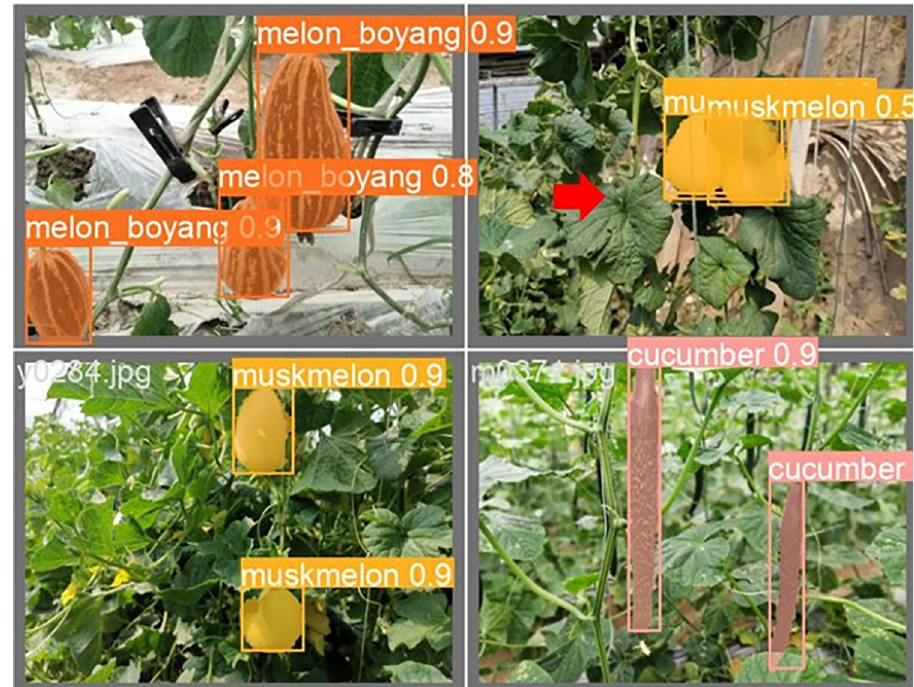
Fig 14. Image results of YOLOv5n.